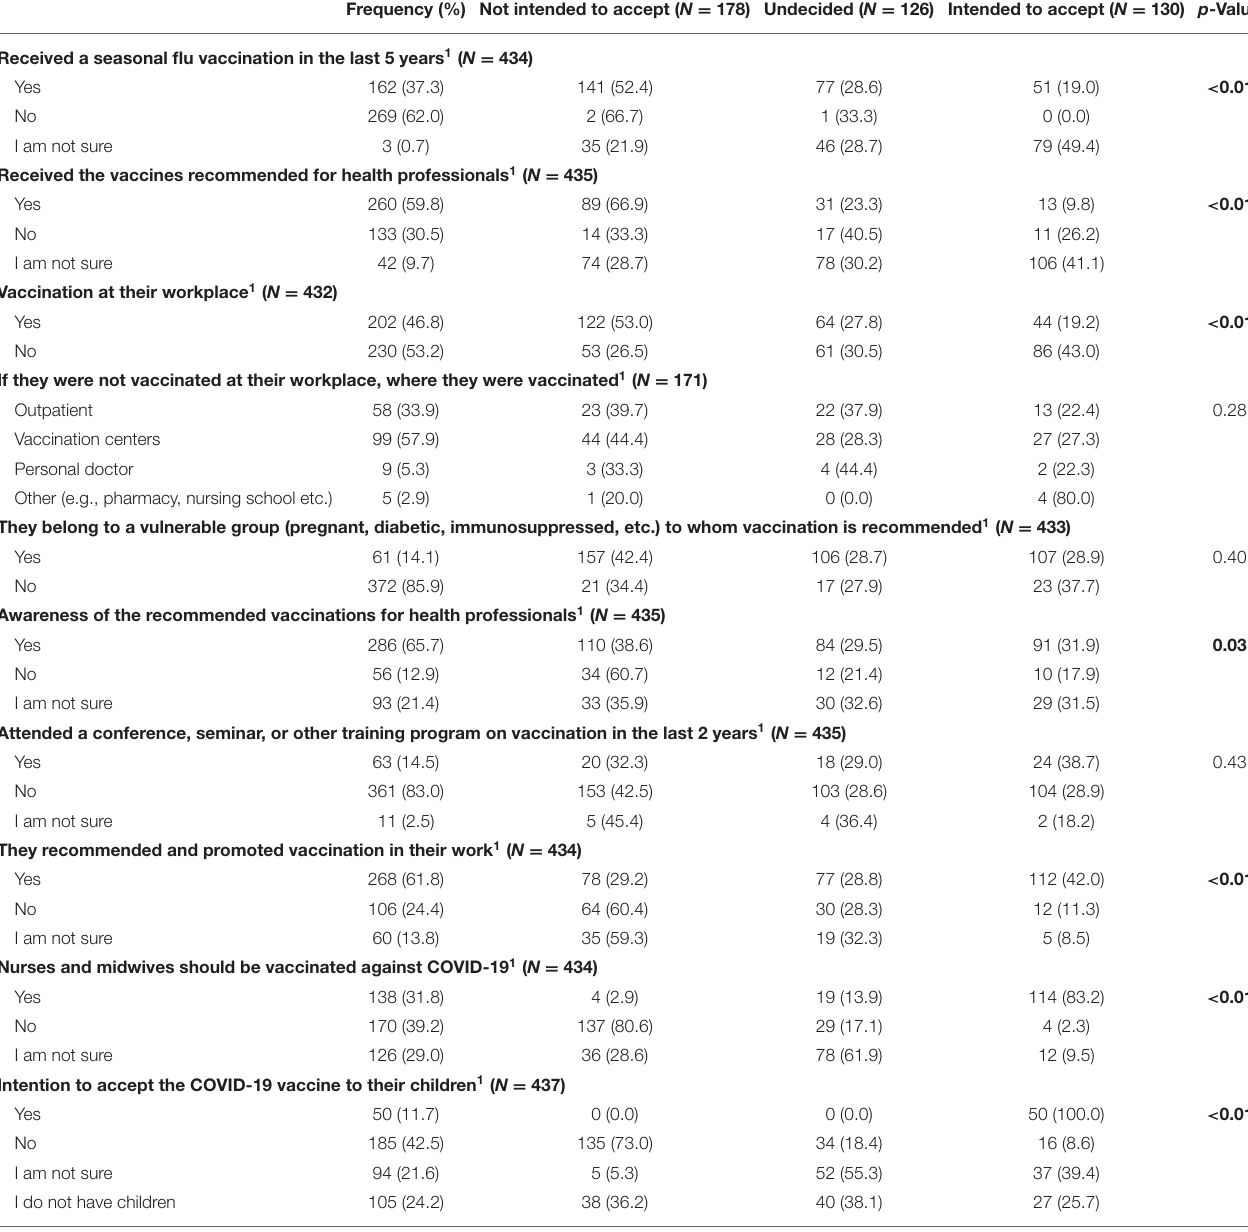
TABLE 2 | Vaccination-related intentions, behaviors, and attitudes on intention to be vaccinated against